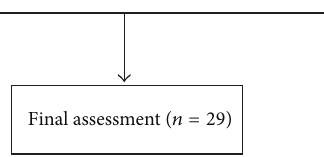
Figure 2: Participant flow chart. THA, total hip arthroplasty.